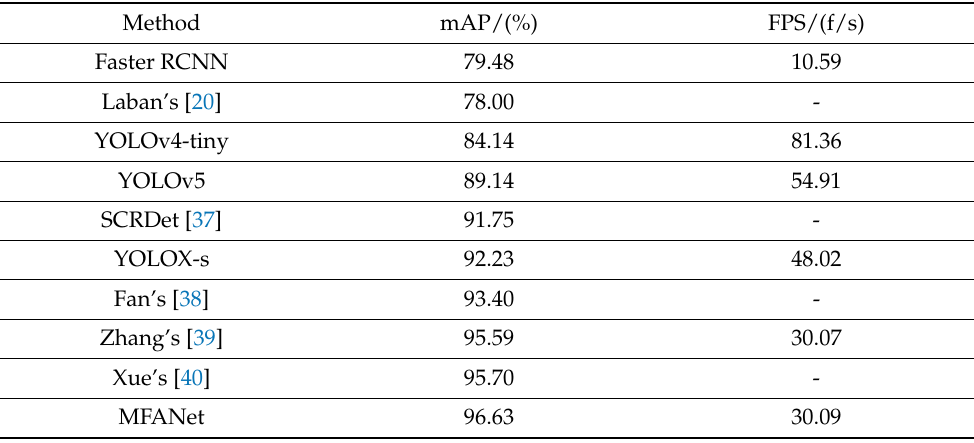
Table 3. Experimental results in the NWPU VHR-10 dataset. FPS stands for frame per second and mAP stands for mean average precision.